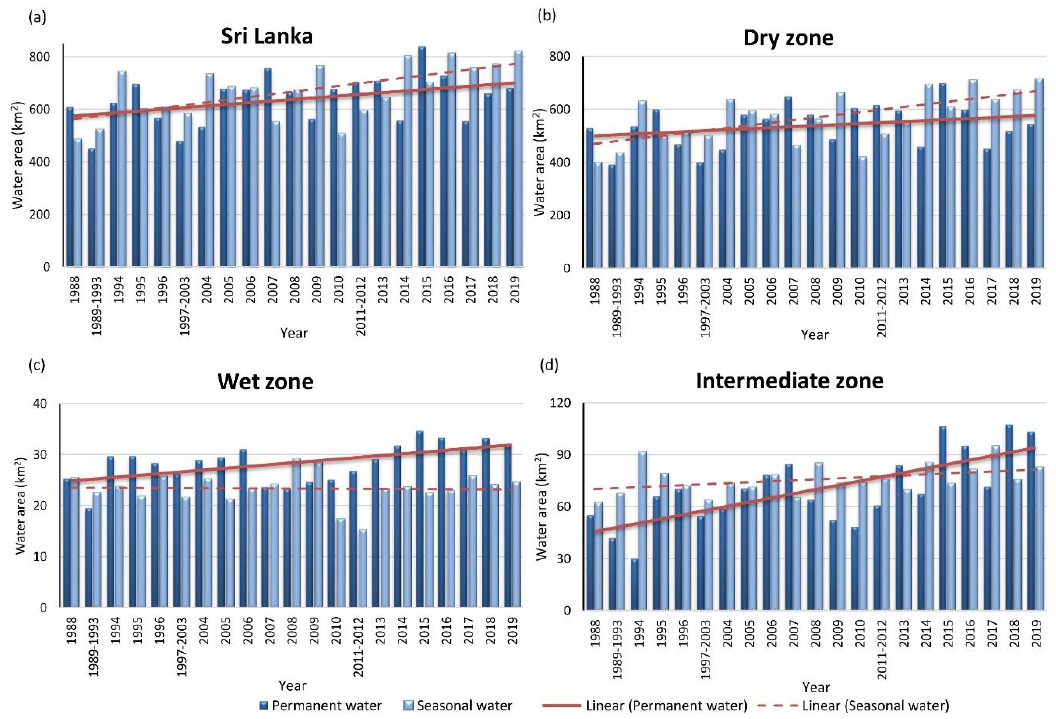
Figure 5. Inter annual variations of surface water area in Sri Lanka. ( a ) Entire country, and different climatic zones: ( b ) Dry zone, ( c ) Wet zone, and ( d ) Intermediate zone during